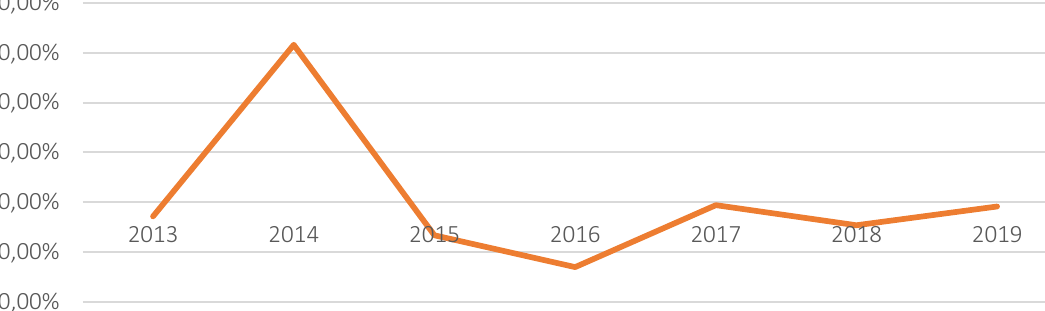
Figure 5. Net income (NI) (2013–2019) Table 3. Pearson correlation